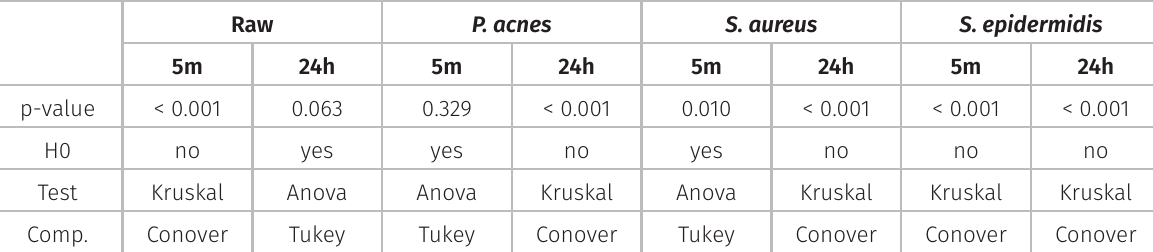
Table I. Normality datas.